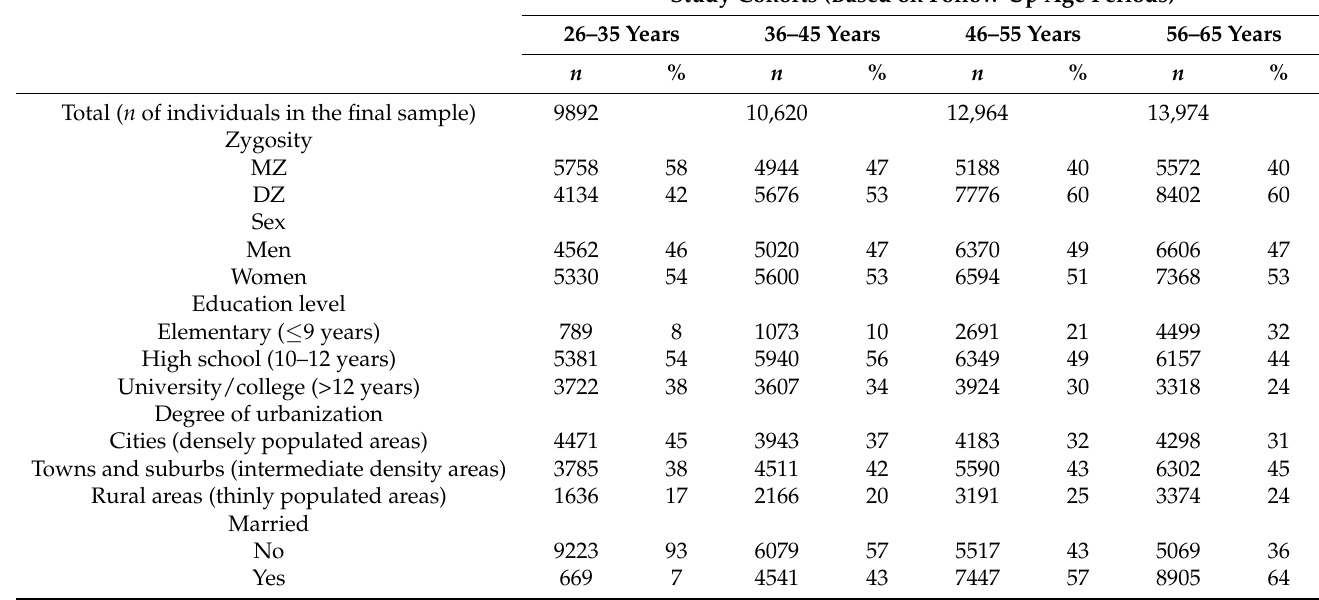
Table 1. Sample characteristics (frequency, n and percentage, % of descriptive characteristics) for the study cohorts.